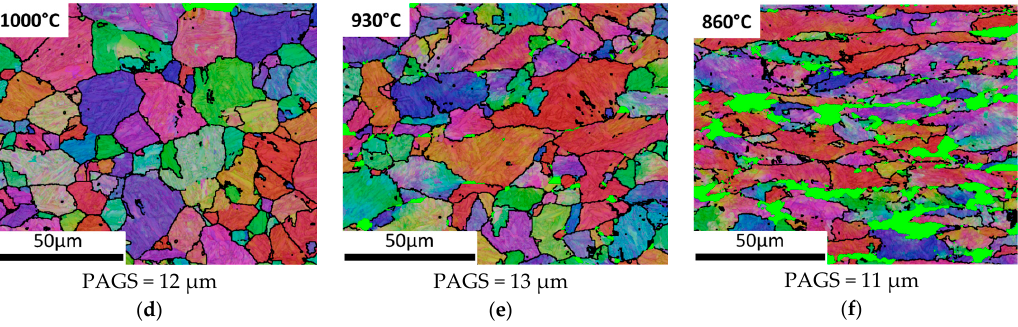
Figure 2. EBSD maps for three different finish rolling temperatures (FRTs) (DQ1 steel): originally measured martensite structure ( a ) FRT 1000 °C, ( b ) FRT 930 °C, ( c ) FRT 860 °C, and reconstructed prior austenite EBSD maps of the same measurements ( d ) FRT 1000 °C, ( e ) FRT 930 °C, ( f ) FRT 860 °C. (Inverse Pole Figure colouring, black lines: 15° boundaries) (Bright green areas in ( e , f ): unreconstructed areas).